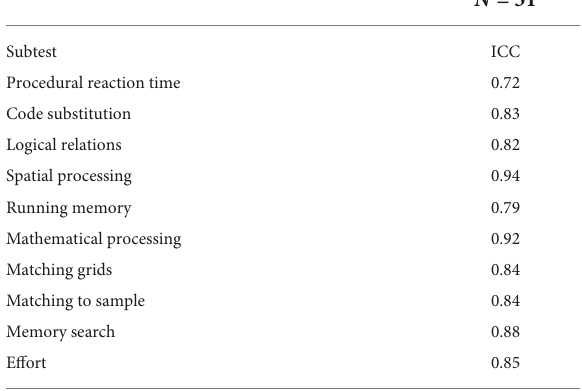
TABLE 7 Intraclass correlation index of Ped-ANAM test-retest reliability.